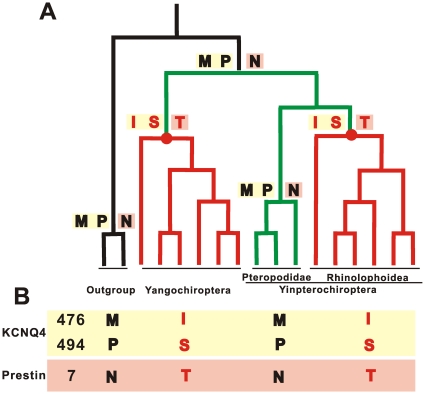
Plot of the number of amino acid changes versus the estimated frequency of best hearing sensitivity.Correlations in the suborder Yangochiroptera and superfamily Rhinolophoidea are significant, respectively (P = 0.011, P = 0.0065). Triangles indicate the two Old World species of bats which indicate the ancestral states.